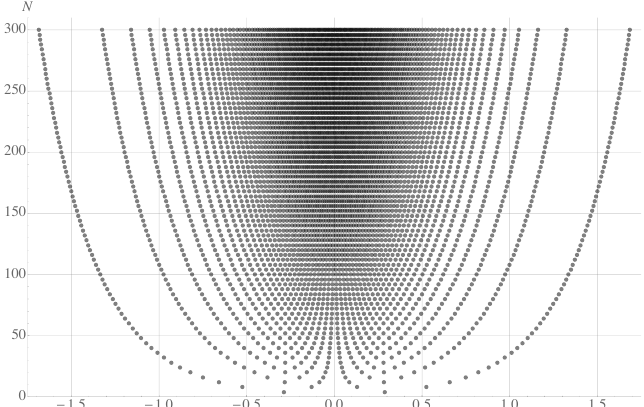
Figure 1: Position of the N / 2 Bethe roots for the ground-state solution to the homogeneous T-Q equation. System sizes range from N = 4 to N = 300 with N / 2